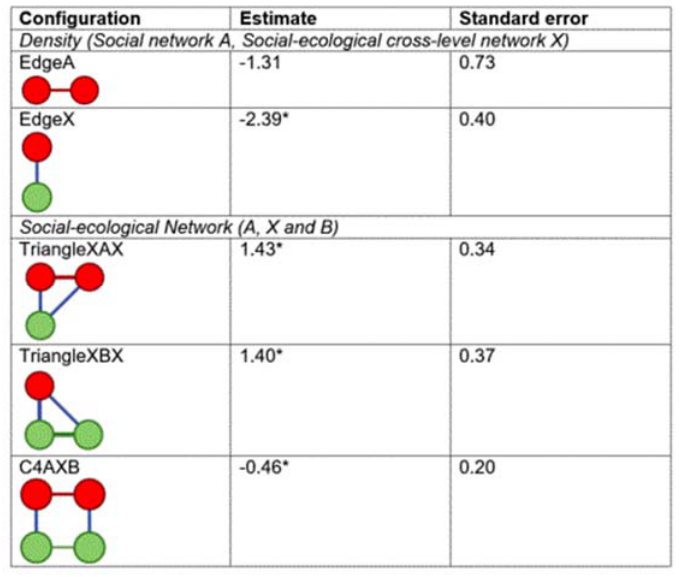
Figure A1.1. A fitted ERGM with a minimal number of tested building